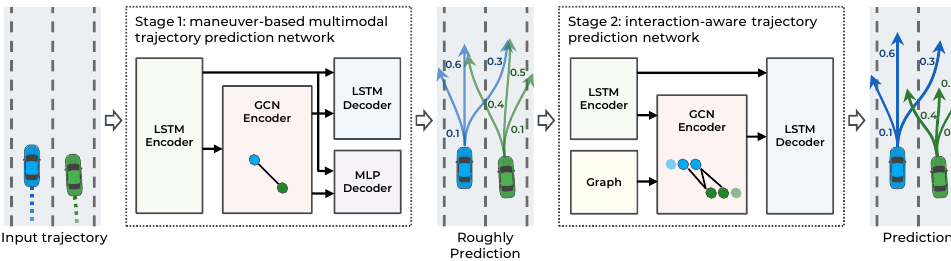
Figure 2. Overall system architecture of the proposed hierarchical trajectory prediction